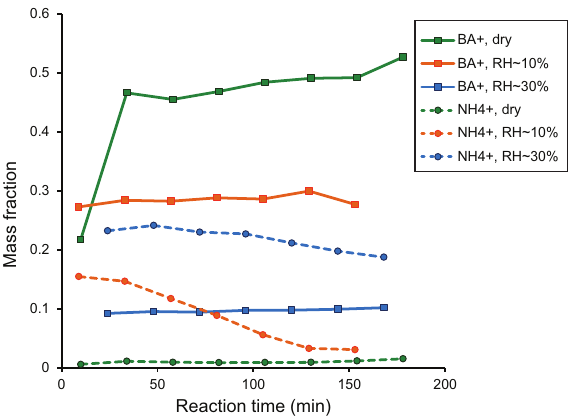
Figure 3. κ measured at different ss showed inconsistence for sec- Figure 2. Fraction of BA + and NH + mass measured by PILS-IC in 4 ondary aerosol formed from BA + N 2 O 5 at RH ∼ 30%. the total aerosol mass for the BA+N 2 O 5 experiments under three different relative humidities (RH<0.1%, 10%, 30%). Table 3. Values of temperature difference ( 1T ), flow rate ( Q ), and the corresponding ss (%) from (NH 4 ) 2 SO 4 calibration of the CCN